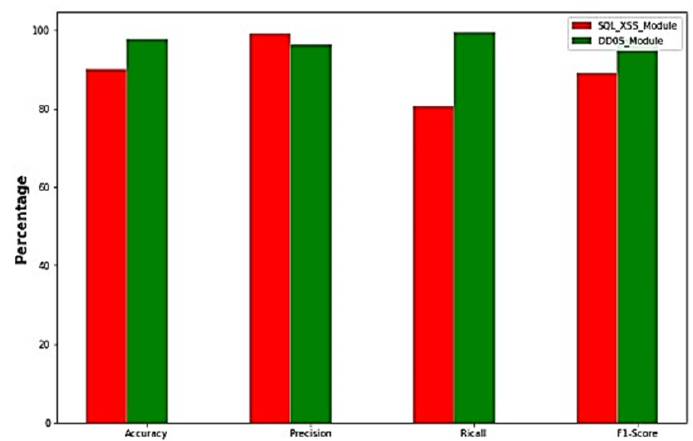
Figure 15. Performance evaluation of